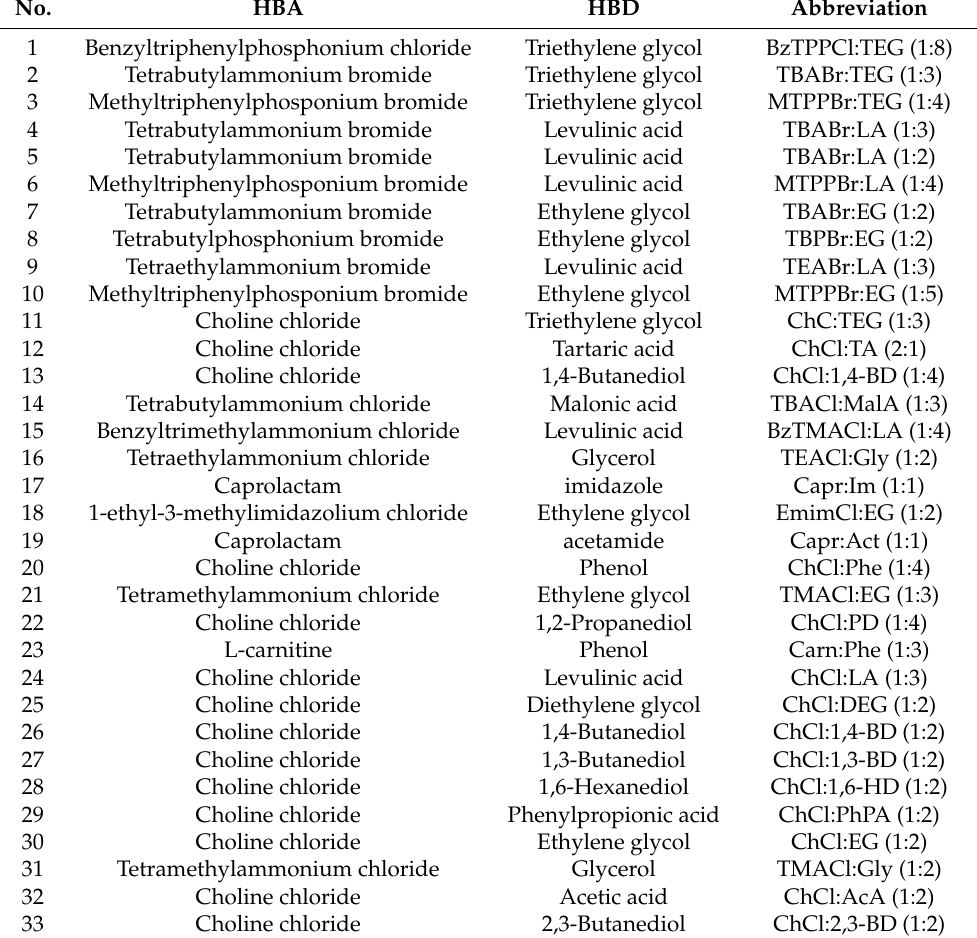
Table 1. List of the shortlisted DESs for COSMO-RS screening. No. HBA HBD